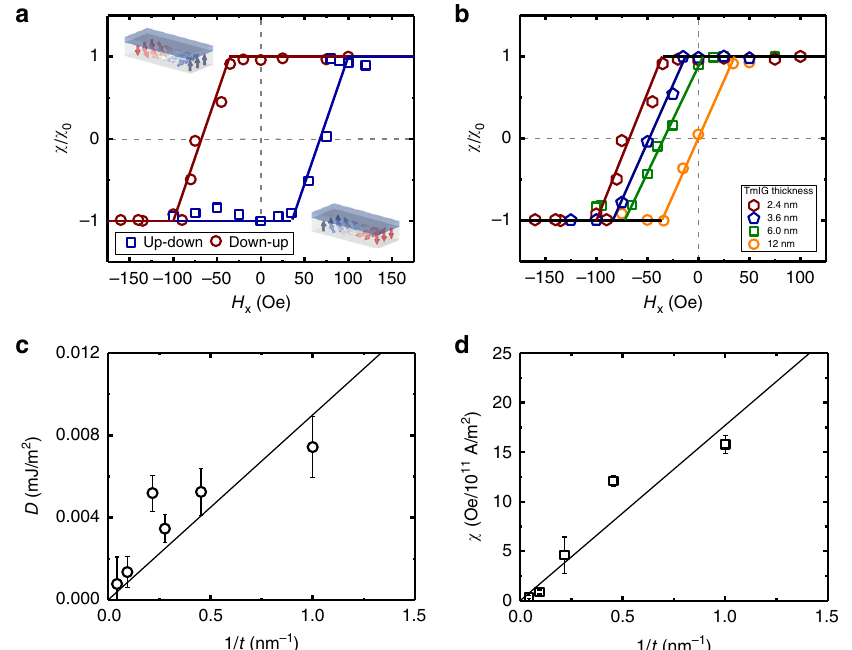
Fig. 3 Thickness dependence of the chiral exchange energy in GGG/TmIG/Pt. a Normalized spin Hall ef fi ciency ( χ / χ 0 ) as a function of in-plane fi eld ( H x ) for up-down (open blue squares) and down-up (open red circles) domain walls. Insets are schematics of up-down and down-up domain walls at zero applied fi eld. b χ / χ fi lms. TmIG thickness ( t ) dependence of the c Dzyaloshinskii – Moriya 0 for down-up domain walls in various thicknesses of GGG/TmIG/Pt interaction energy ( D ) and d the spin Hall ef fi ciency. Error bars in c are the propagated error of measured M s , Δ , and H D at each thickness, while the error bars in d are the standard error of 4 – 6 measurements at each thickness. Source data for c and d are provided as a Source Data fi le.